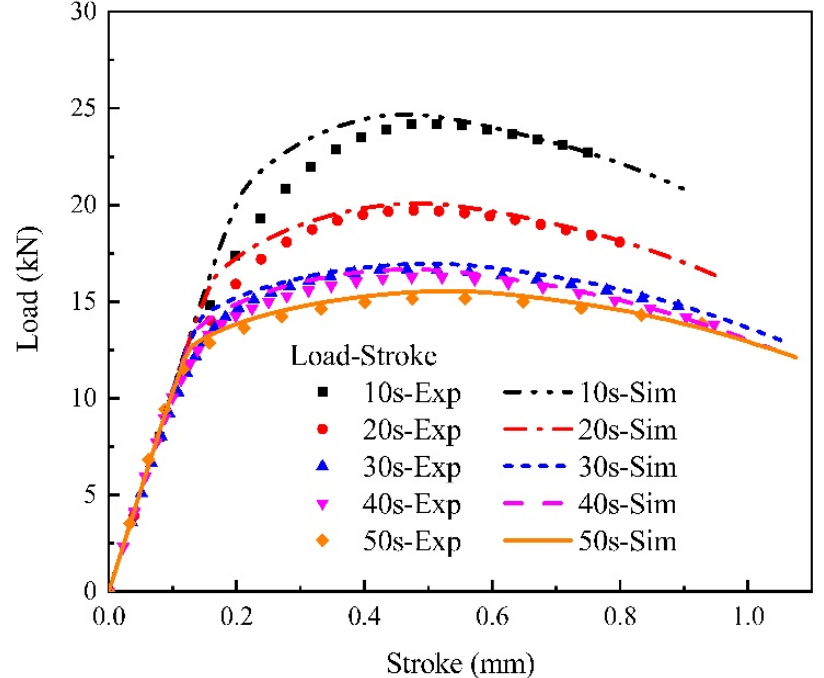
Figure 11. Load–stroke curve comparisons between experiment and simulation for different holding times (the dots represent experimental values and the lines represent simulated values).